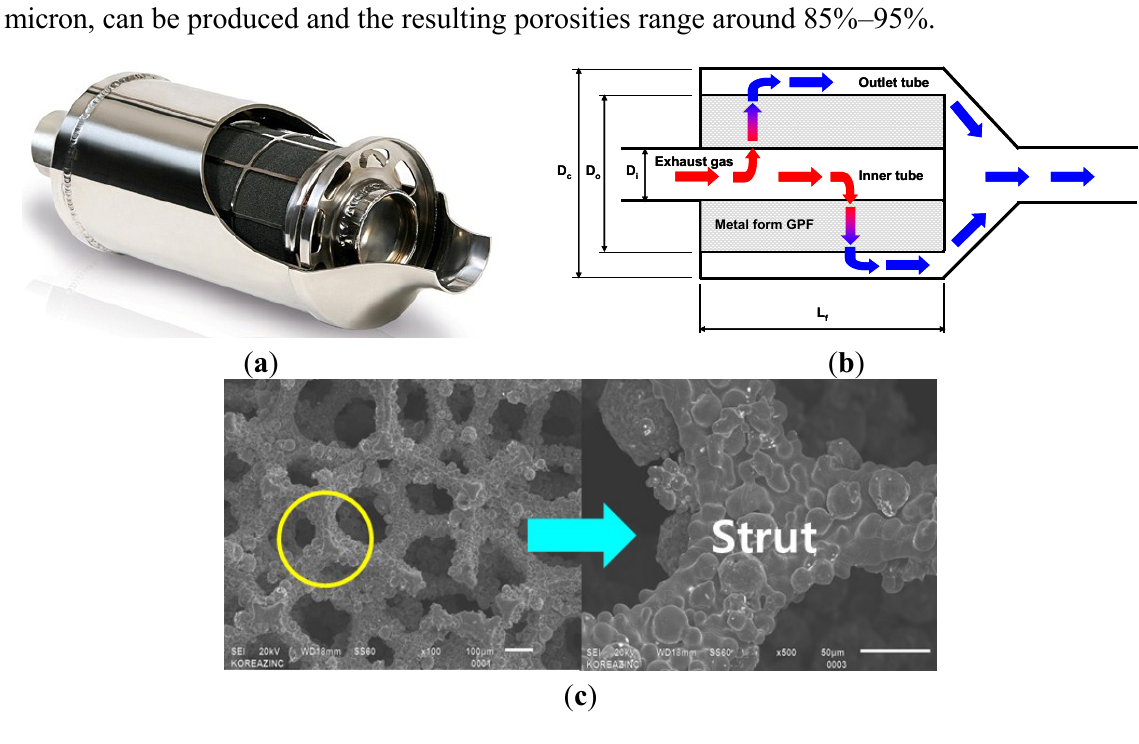
Figure 1. Geometry of a radial type metal foam filter for GDI engine; ( a ) external appearance of the metal foam GPF; ( b ) exhaust gas flow and the geometry of the GPF; ( c ) images of metal